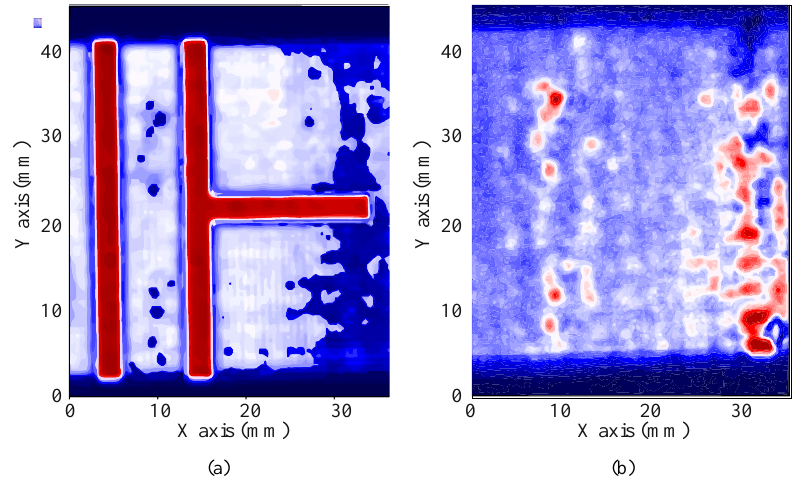
Figure 10. Examples of adhesion errors seen using resonant spectroscopy ( a ) and time analysis ( b ).